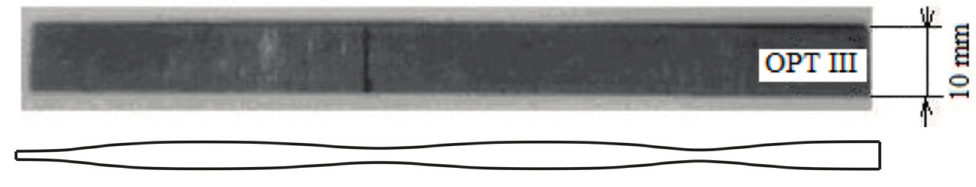
Figure 15. Technical drawing of the fabricated